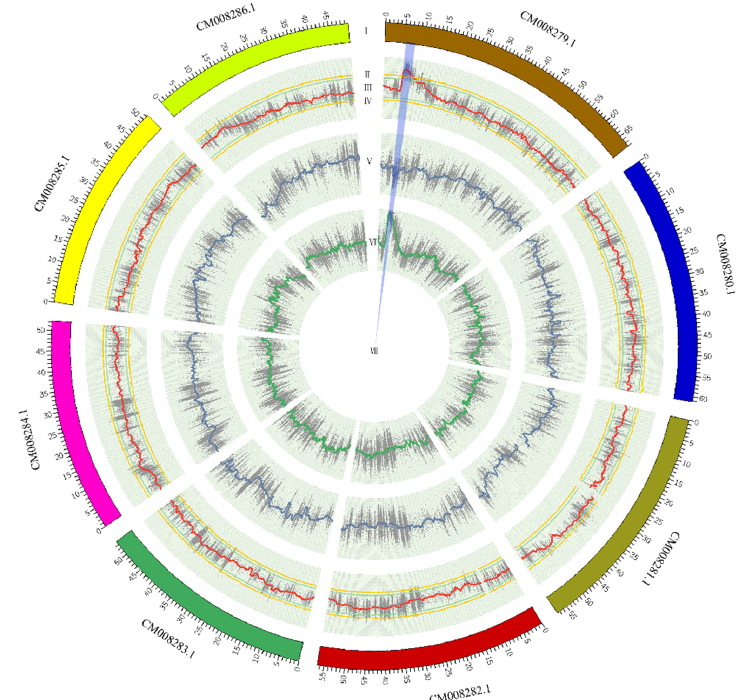
Figure 4. Candidate target region underlying easy dehulling of rice-Tartary: The panels from outside to inside were ( Ⅰ ) chromosomes; (II, III) the confidence intervals of 99% and 95% for delta SNP-index; (IV) Delta SNP-index; (V) SNP-index for K5; (VI) SNP-index for K21; and (VII) Candidate region.